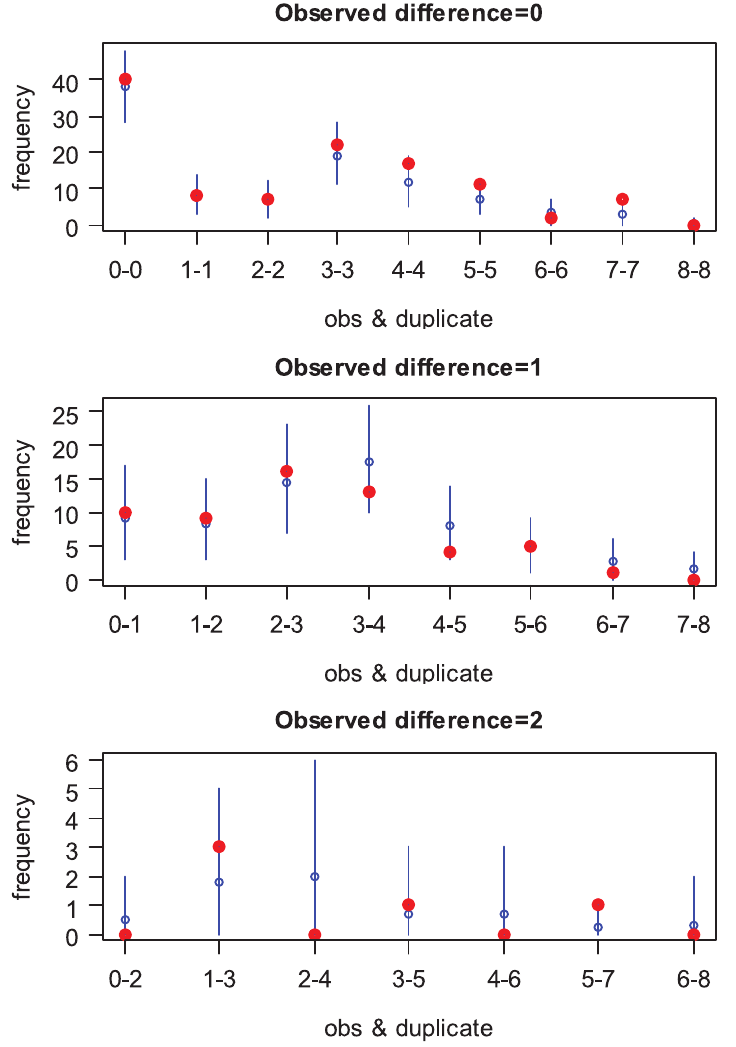
Figure 1. Fit of the model to data on replicate measurements. Observed (red point) and expected (mean: blue point/95% CI: blue bar) number of pairs (observed AT level, replicate AT level). Pairs are sorted by panel according to the number of dilution difference between the observed and the replicate measurement.